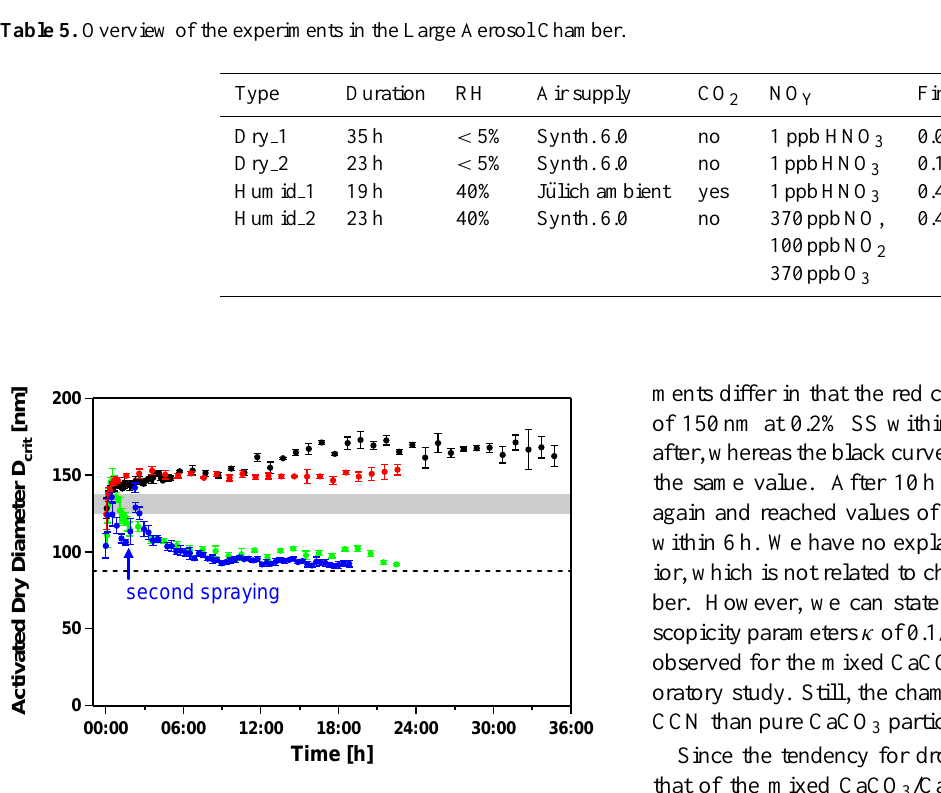
Fig. 10. Time series of activated dry diameters ( D crit ) of cal- Figure 10. Time series of activated dry diameters (D crit ) of calcium carbonate aerosols at cium carbonate aerosols at 0.2% SS measured in the Large Aerosol 0.2 % SS measured in the Large Aerosol Chamber filled with dry synthetic air (two Chamber filled with dry synthetic air (two experiments: red and experiments: red and black), with particle free outside air (containing CO 2 (g)) at ~40% RH black), with particle free outside air (containing CO 2 (g)) at ∼ 40% RH (blue) and synthetic air at RH ∼ 40% and 470 ppb NO x (green), (blue) and synthetic air at RH ~40% and 470 ppb NO X (green), dashed line: D crit (Ca(NO 3 ) 2 ) dashed line: D crit (Ca(NO 3 ) 2 ) by Sullivan et al. (2009b), grey area: by Sullivan et al. (2009b), grey area: D crit (Ca(HCO 3 ) 2 from this study. Error bars are the D crit (Ca(HCO 3 ) 2 from this study. Error bars are the standard de- standard deviation of each measurement interval. viation of each measurement